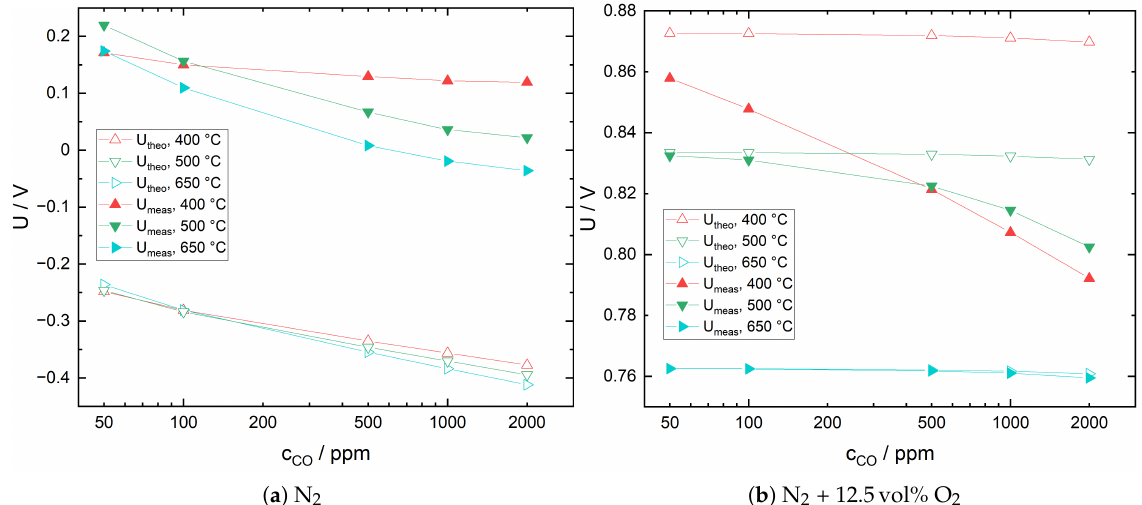
Figure 5. Sensor with Pt cermet sensing electrode under CO exposure in two different sample gas mixtures. Comparison of measured sensor voltages (U_meas) with theoretical values (U_theo) calculated under the assumption of complete equilibration of CO with available O 2 . All voltages are versus Ni/NiO reference